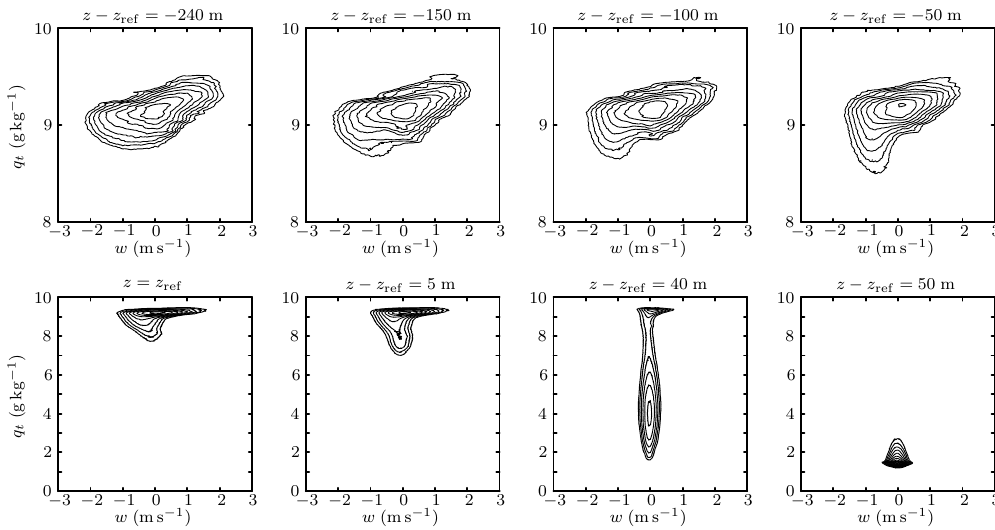
Figure 8. Joint probability density functions of total water mixing ratio and vertical velocity. Each panel corresponds to different height. The heights are with respect to the height of the maximum mean cloud liquid z ref . The contours are plotted in logarithmic